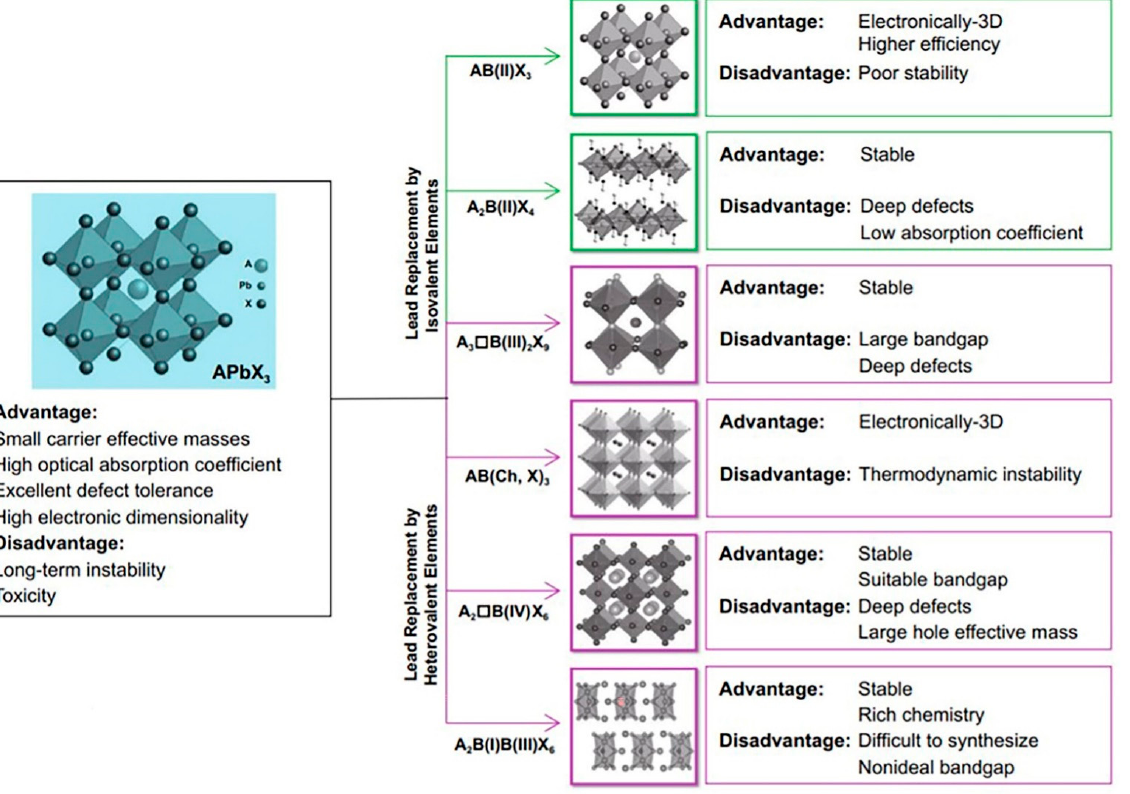
Figure 22. Schematic diagram of the methods and significances of potential Pb replacement [193]. Copyright 2021